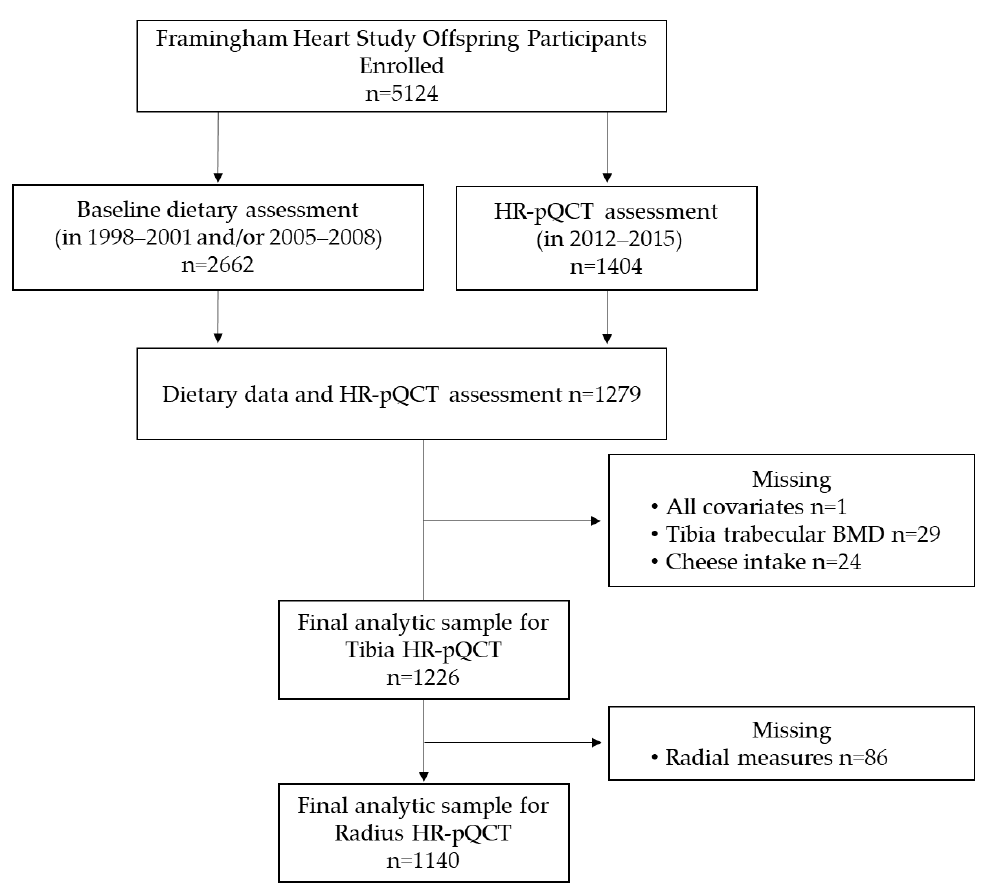
Figure 1. Flow chart of Framingham Heart Study Offspring cohort participants included in the HR-pQCT analysis. HR-pQCT